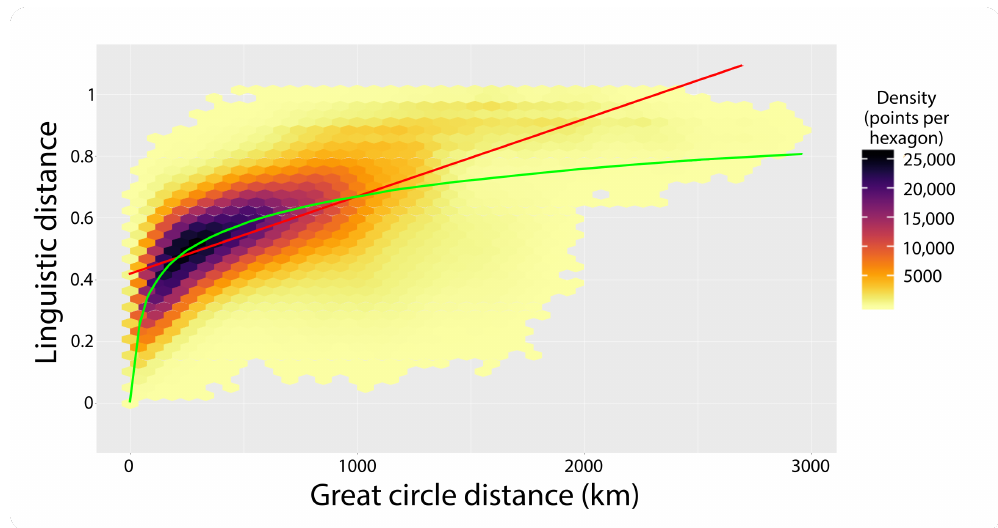
Figure 11. Linguistic distance plotted against the great circle distance in the entire survey area. The colour of each hexagon represents the number of location pairs’ value falling into it. Regression lines are plotted for showing the linear (in red) and the logarithmic (green)